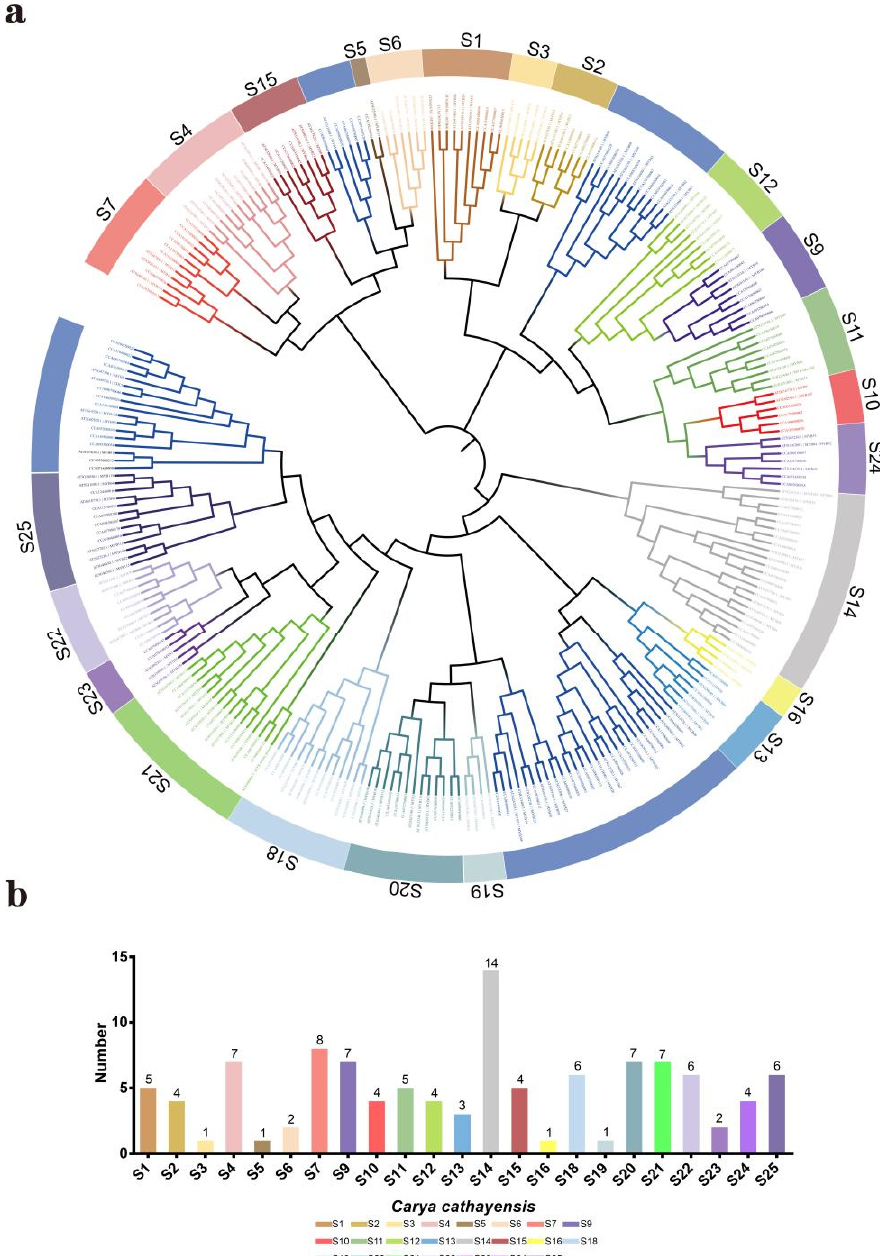
Figure 1. Genome-wide identification and classification of R2R3-MYB family genes in Carya cathayensis . ( a ) Phylogenetic tree of hickory and Arabidopsis R2R3-MYB family genes generated by neighbor joining (NJ) method in MEGA 7.0. ( b ) Quantitative statistics of CcR2R3-MYB family genes in different subgroups. The number above each column represents the number of genes in each subclass.